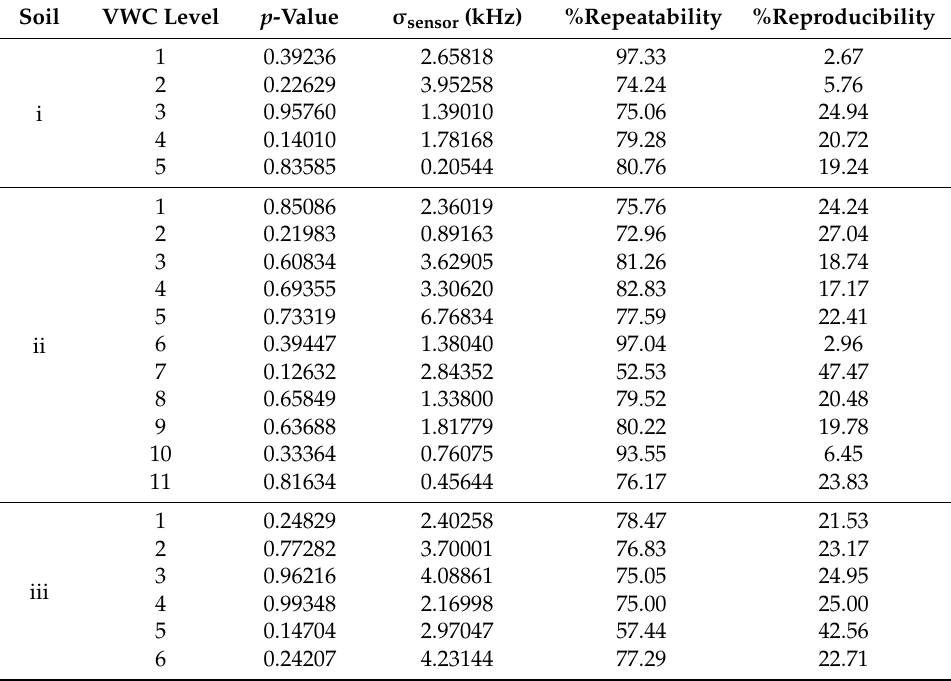
Table 1. ANOVA test results and variability